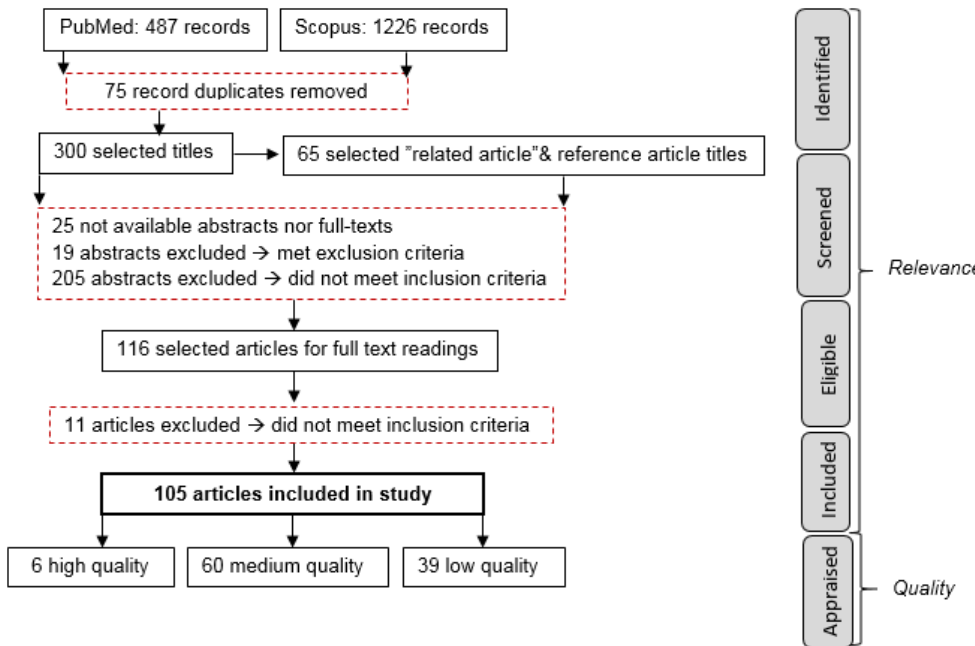
Figure 2. Study flow from identification through screening of relevance and